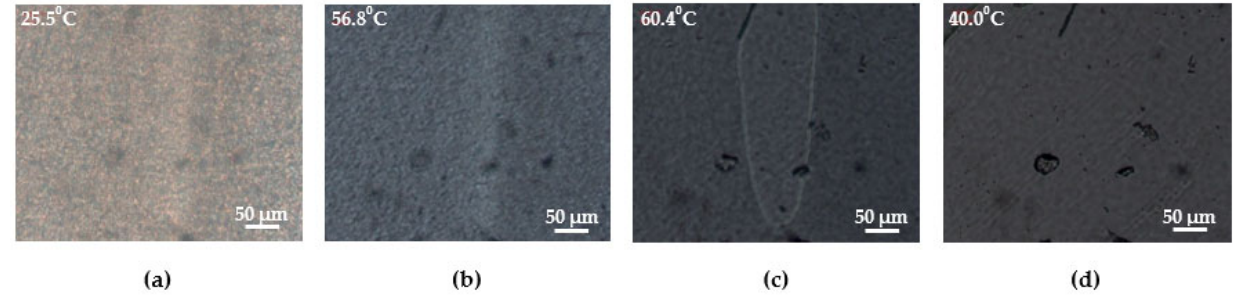
Figure 11. POM micrographs of the multiblock PUU of the composition S6 made at different tem ‐ peratures: 25.5 ( a ), 56.8 ( b ), 60.4 ( c ), and 40.0 °C ( d